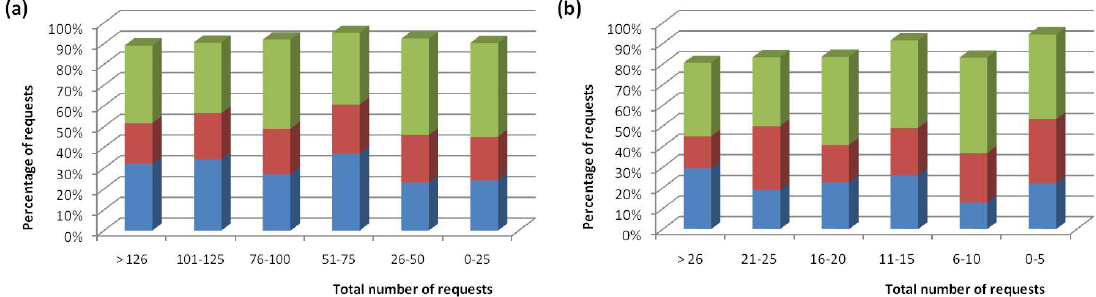
Fig. 5. Bars in different colour show the percentage of requests in the periods discussed in the text grouped into six classes according to the total number of requests for: (a) Catalonia and (b) the Balearic Islands.